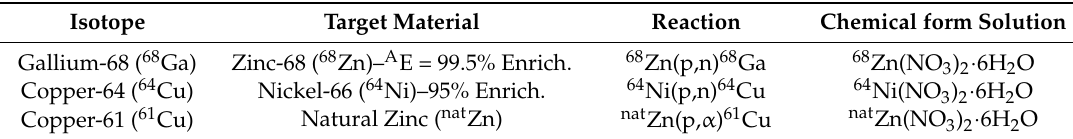
Table 1. Composition of various solutions used.